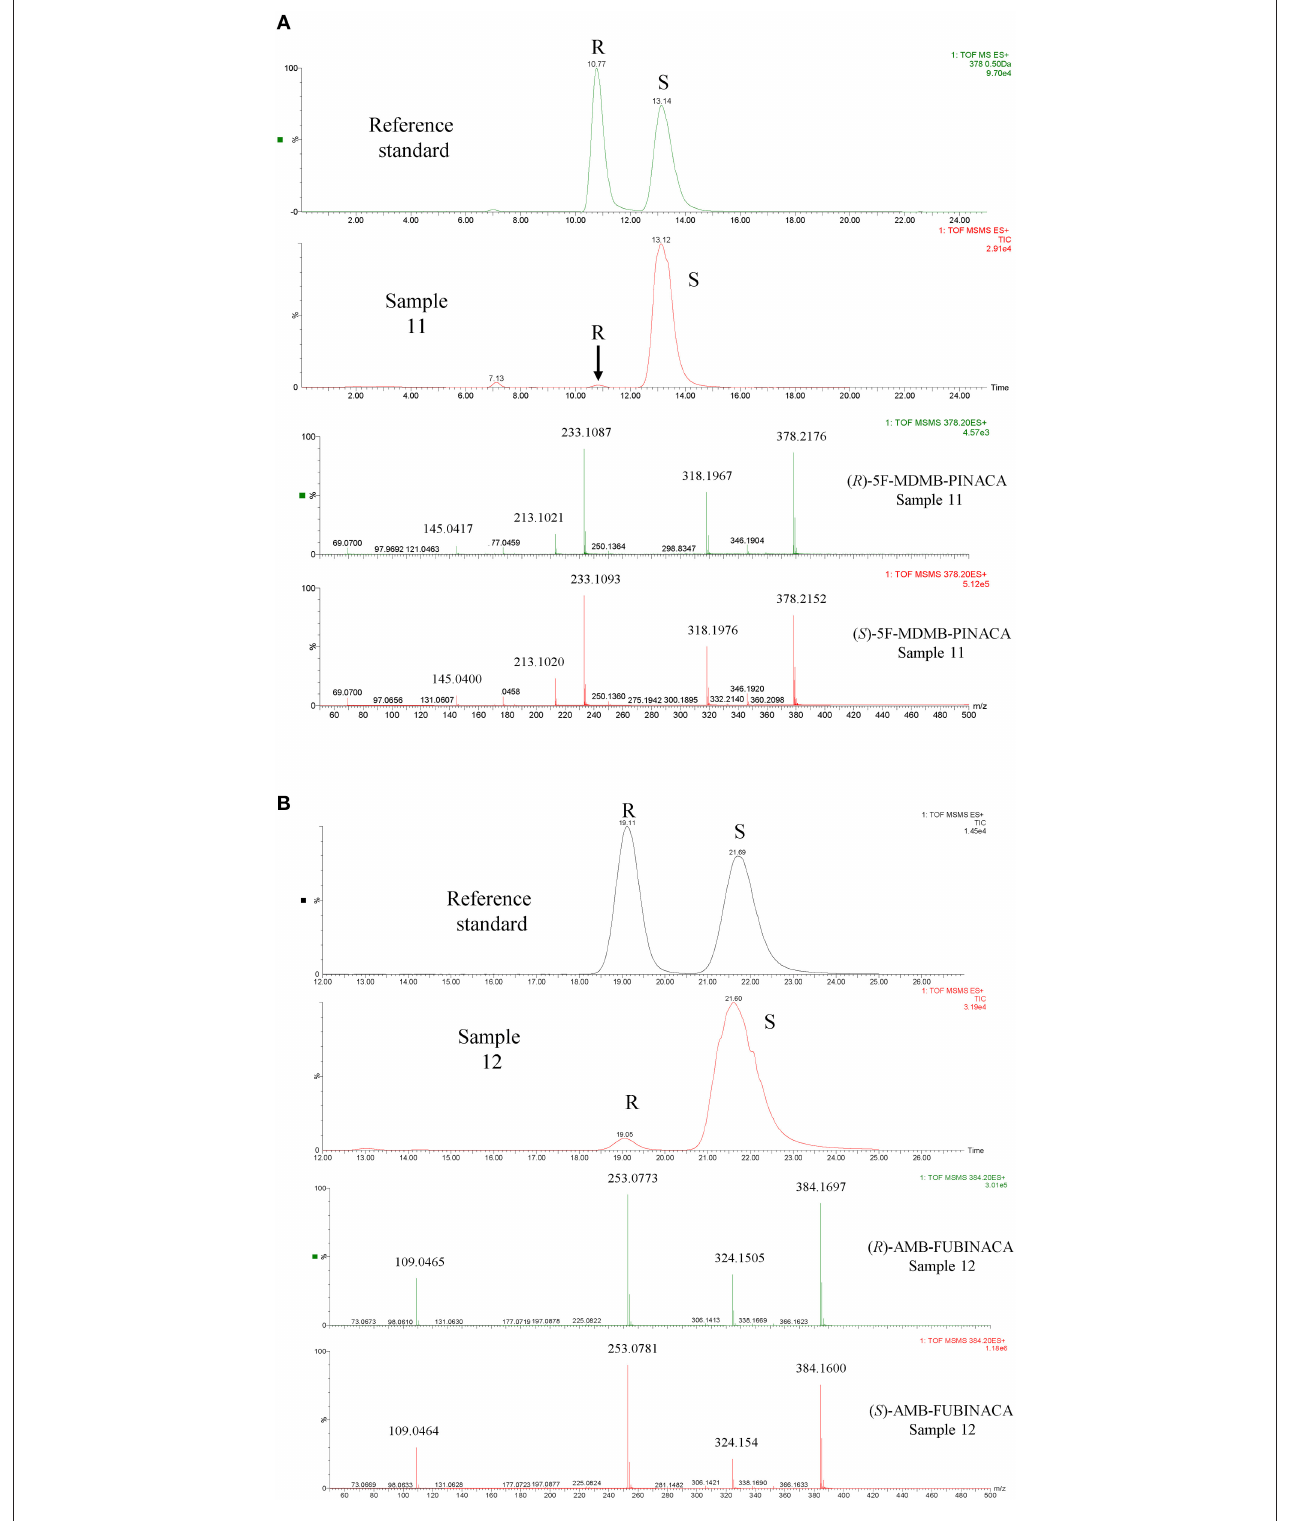
FIGURE 6 | Examples of the identification of SCRA enantiomers in seized samples by Chiral UPLC ® -QToF-MS/MS (A) sample 11 containing 5F-MDMB-PINACA and (B) sample 12 containing AMB-FUBINACA. The most important accurate mass data has been enlarged in the spectra provided for ease of viewing.